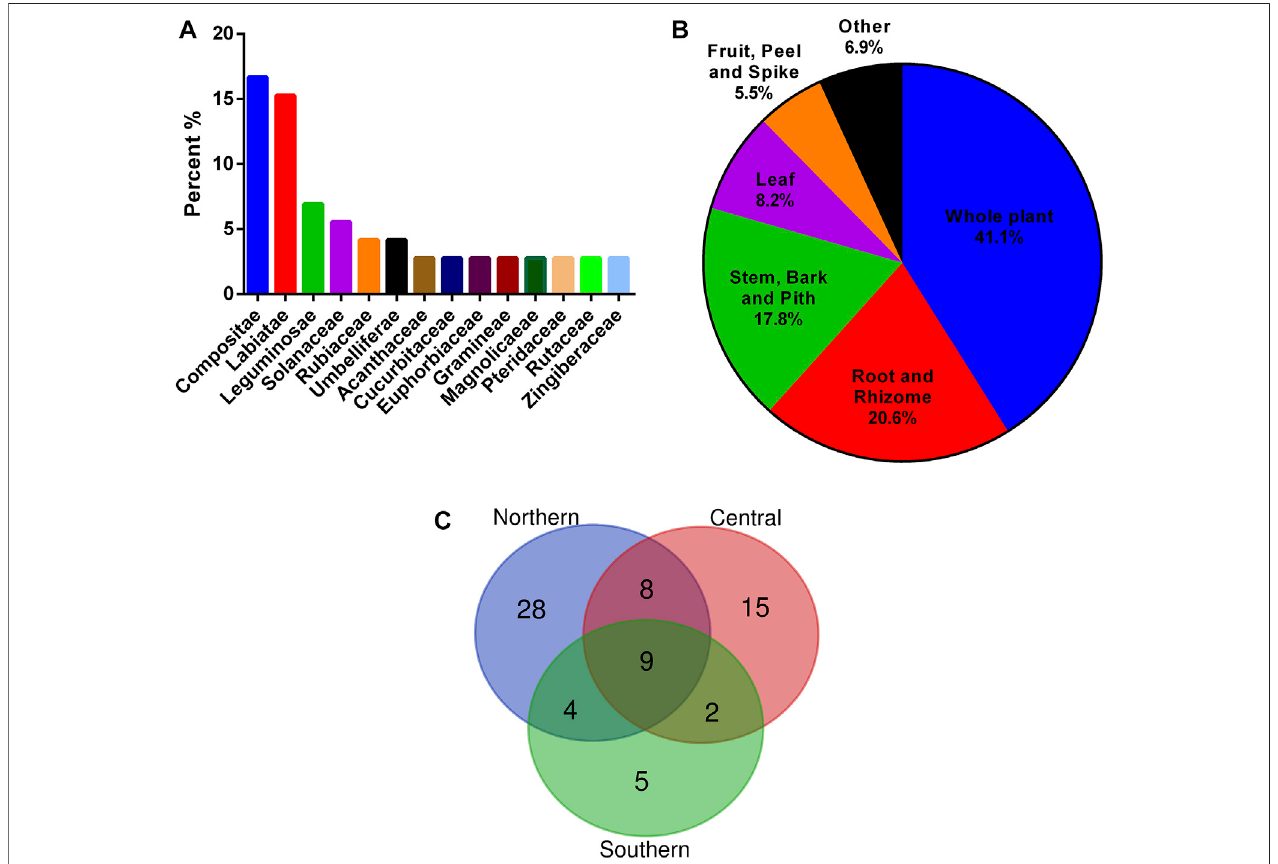
FIGURE 2 | Origin analysis of 73 plant materials used in bitter tea. (A) Families; (B) plant parts; (C) the number of shared plant materials in areas of